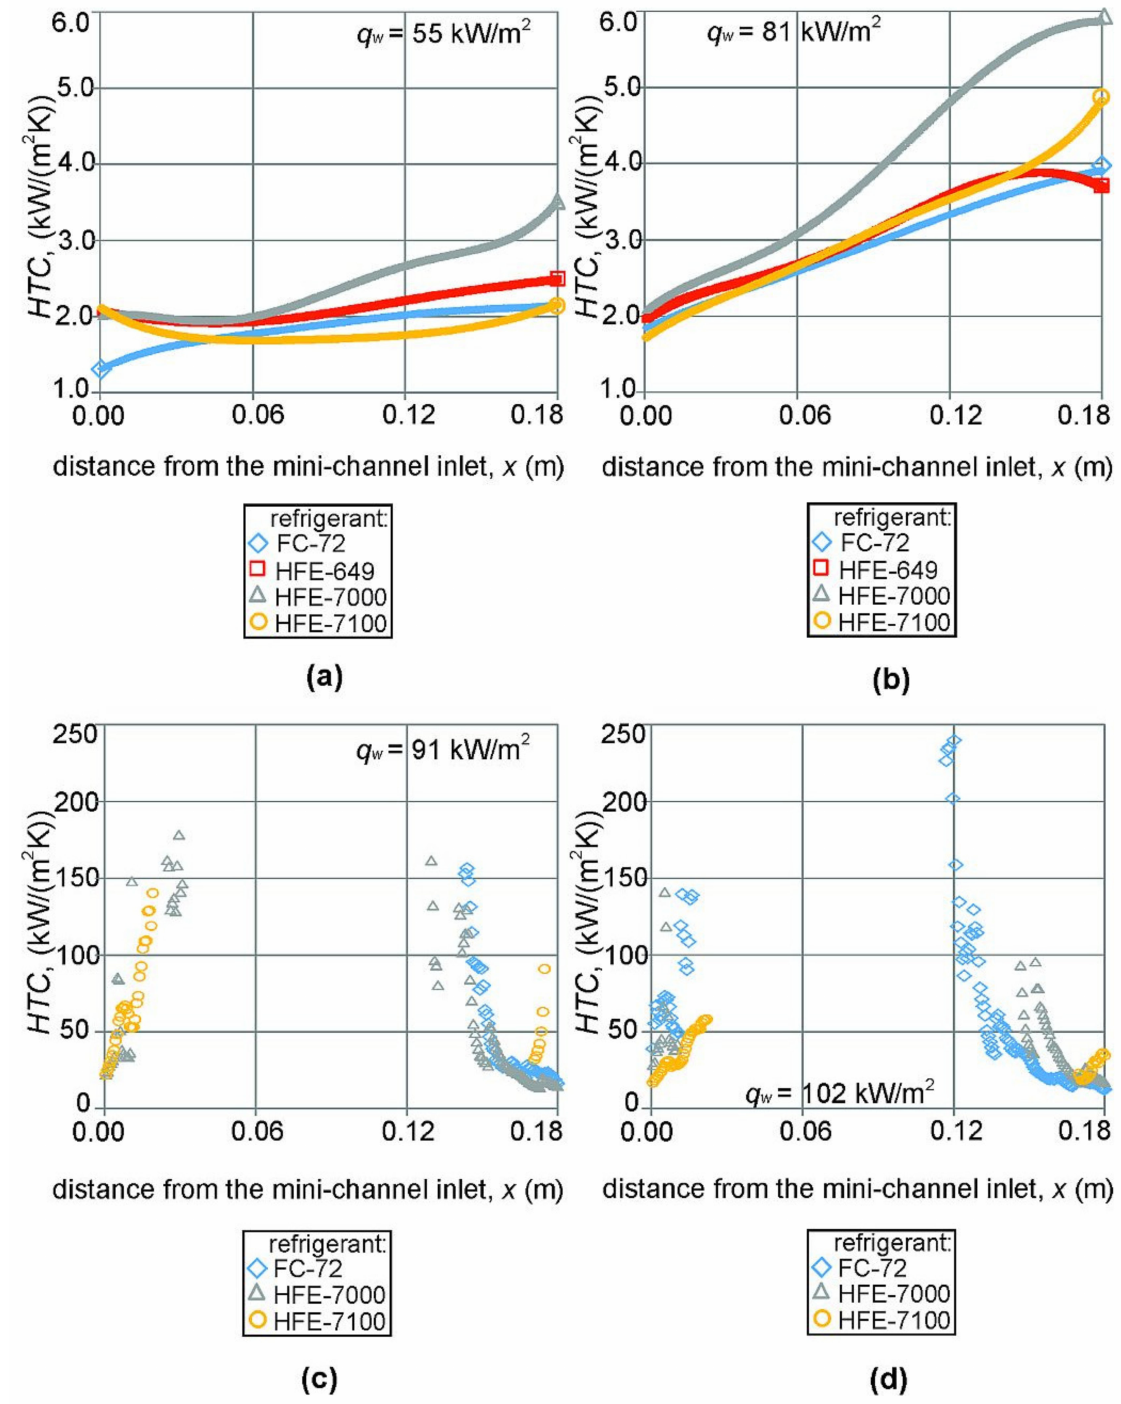
Figure 10. Heat transfer coefficient vs. distance from the mini-channel inlet: subcooled boiling region ( a , b ) and saturated boiling region ( c , d ); various refrigerants; vertical channel orientation (90 ◦ ); average mass flux of 435 kg/(m 2 · s), modified heated plate surface (vibration-assisted laser surface texturing No. 2); FC-72; L IRT = 180